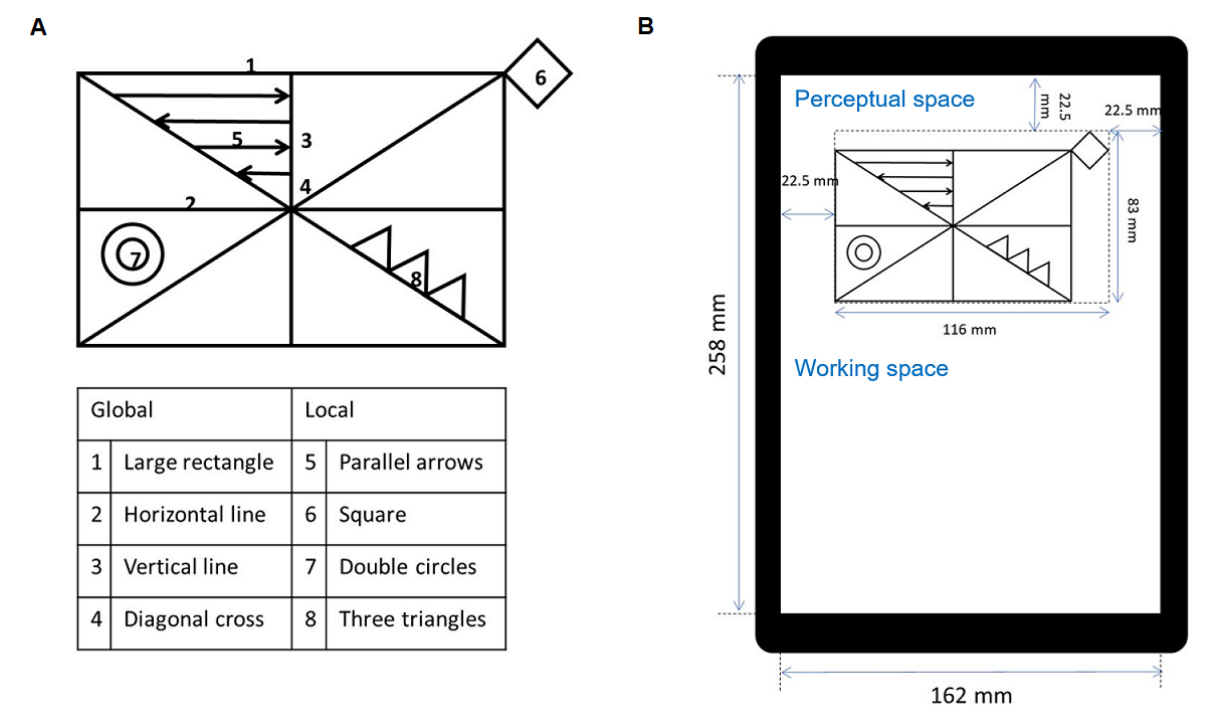
Figure 1. The simplified Rey-Osterrieth Complex Figure Test (RCFT). (A) The simplified RCFT consists of 4 global and 4 local components. (B) The simplified RCFT is shown on a tablet (size: 12 in; resolution: 2160 × 1440; Samsung Galaxy Book 12, Samsung Electronics) with a screen width of 162 mm and a screen height of 258 mm. The texts indicated in blue were not presented to the participants during